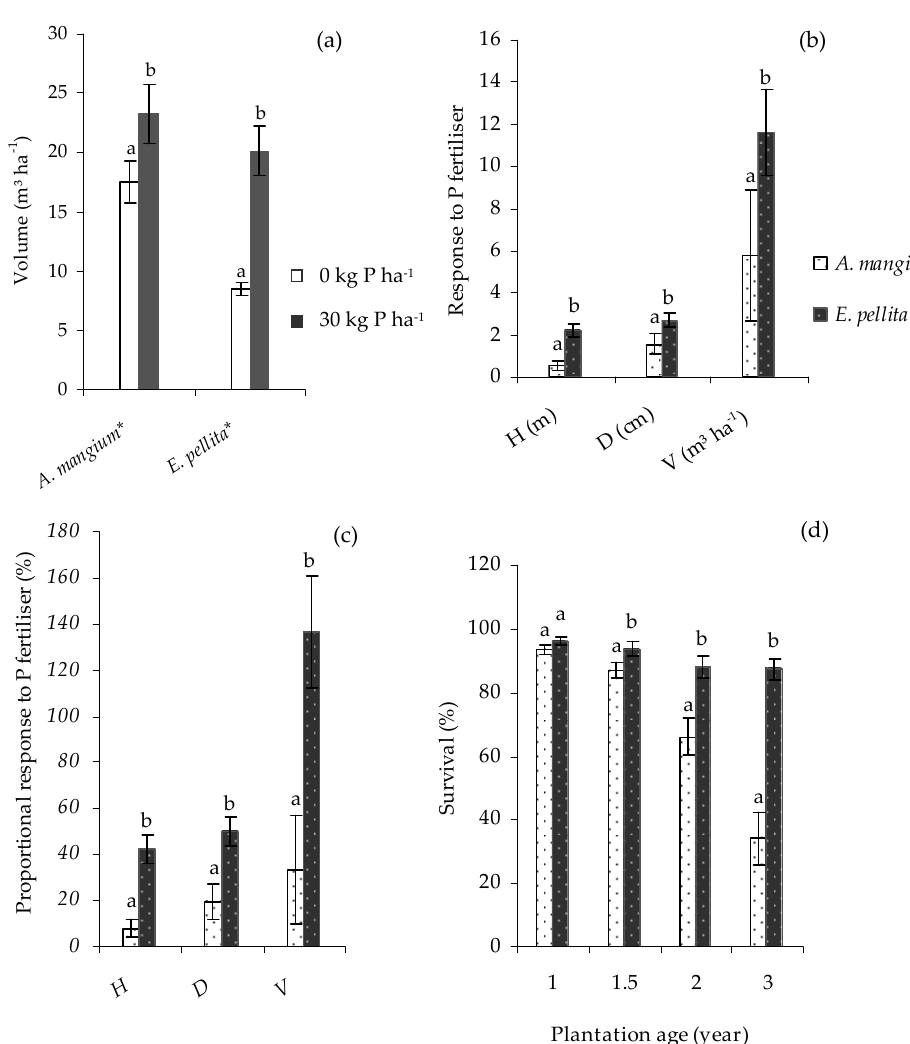
Figure 5. Standing volume, V of Acacia mangium and E. pellita ( a ); and absolute ( b ) and proportional ( c ) growth responses to P fertiliser at age 1.5 y in the Core experiment; and survival rates at ages 1–3 y ( d ). An error bar represents one standard error. Volume response is the di ff erence between the volume of unfertilised and fertilised treatment, while proportional response is volume response divided by the volume of unfertilised treatment, expressed as a percentage. Within the same species or planting age, bars having the same letter did not di ff er significantly according to ANOVA ( p < 0.05).